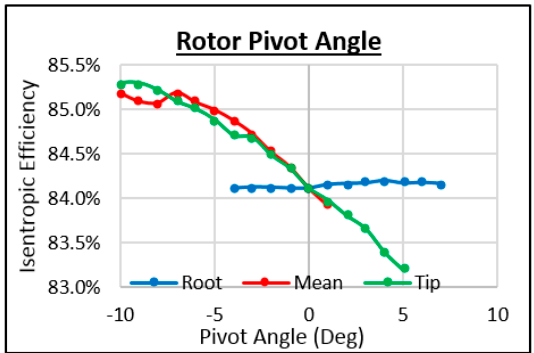
Figure 30. Study of the rotor pivot angle.